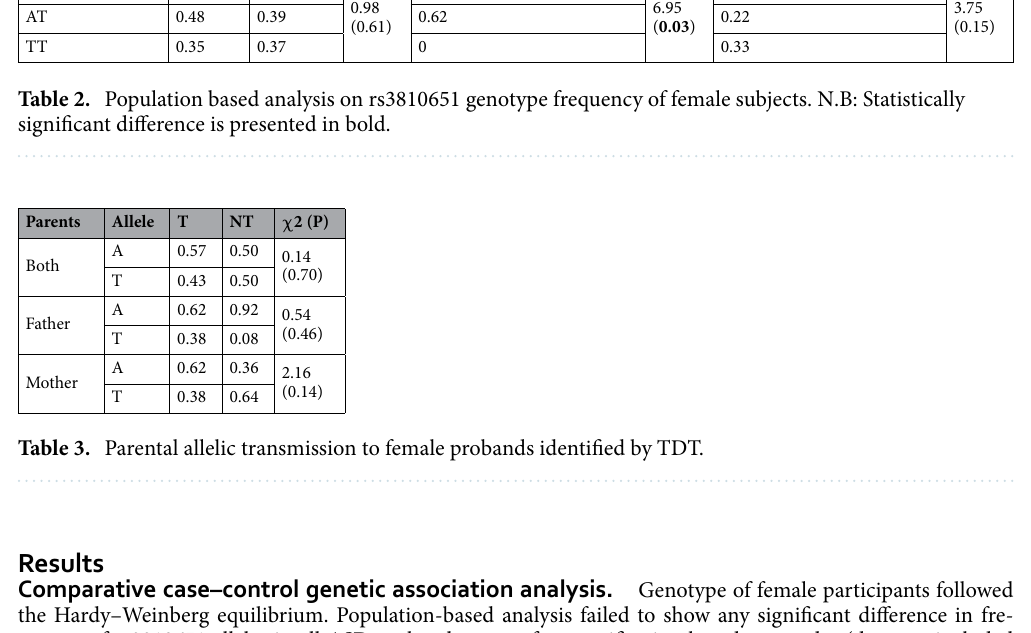
Allele/ genotype